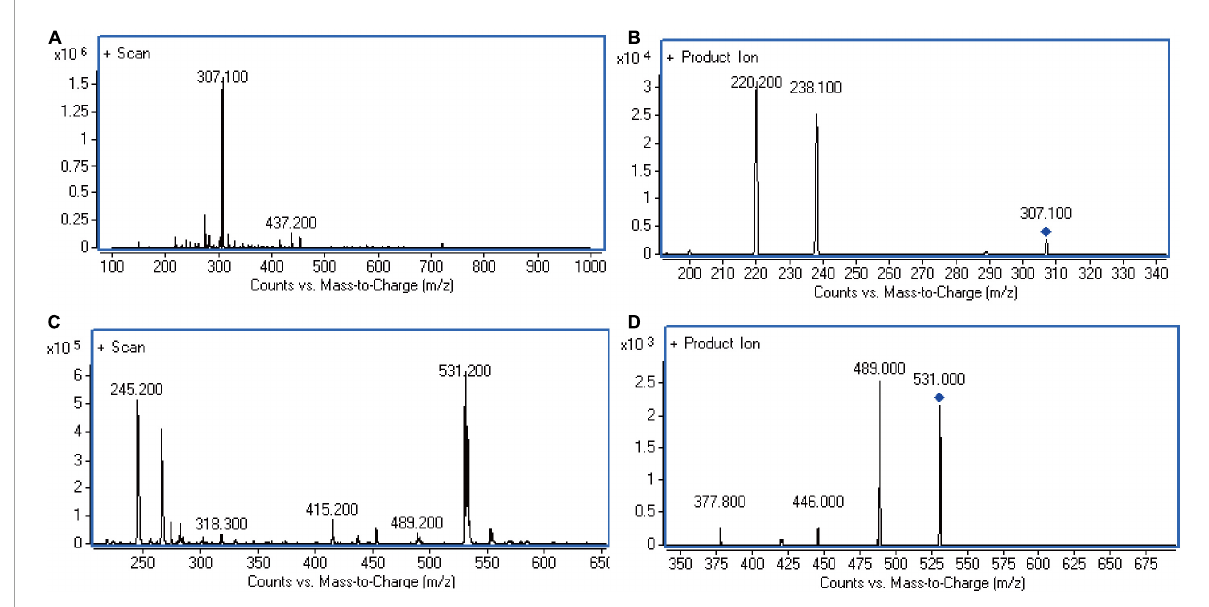
FIGURE1 LC-MS/MS chromatograms. (A) Full-scan of FLC in standard solution. (B) Product ion of FLC in standard solution. (C) Full-scan of KCZ in internal standard solution. (D) Product ion of KCZ in internal standard solution. The representative results of three independent experiments are